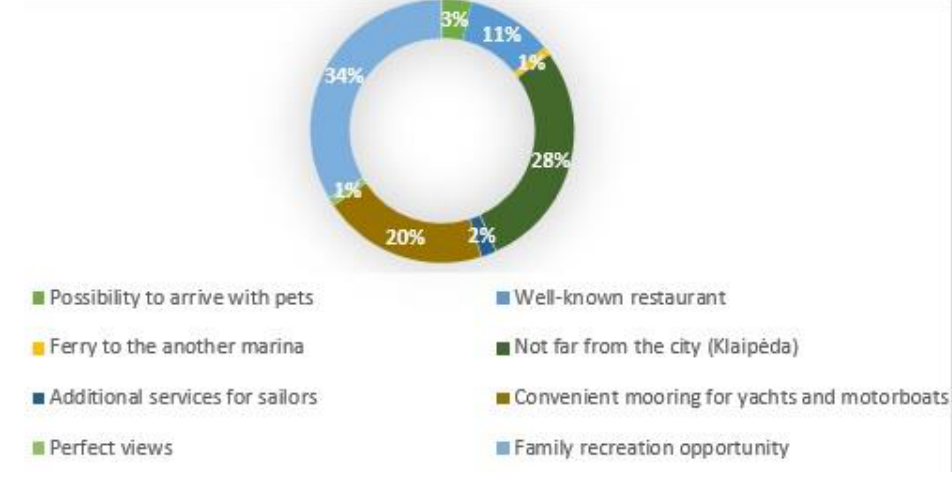
Figure 1. The factors of the marina services enticed customers to use the marina.